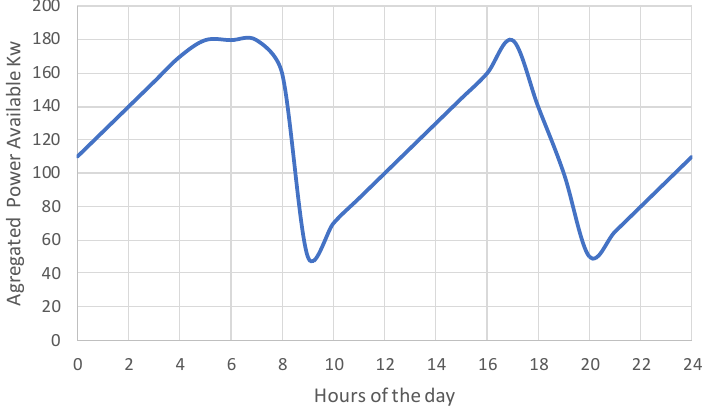
Figure 9. Aggregation data from the seven EV in an average daily distribution.